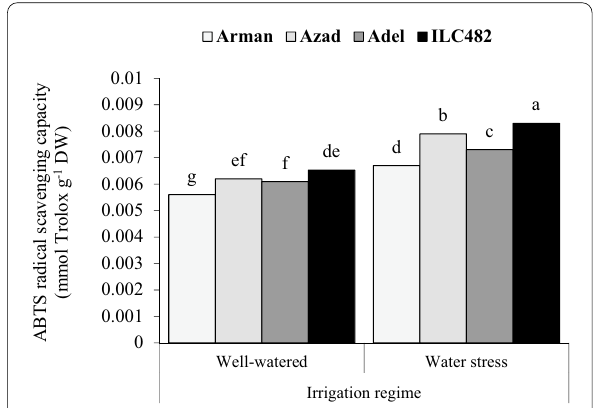
Fig. 6 Two-way interaction of irrigation regime radical scavenging